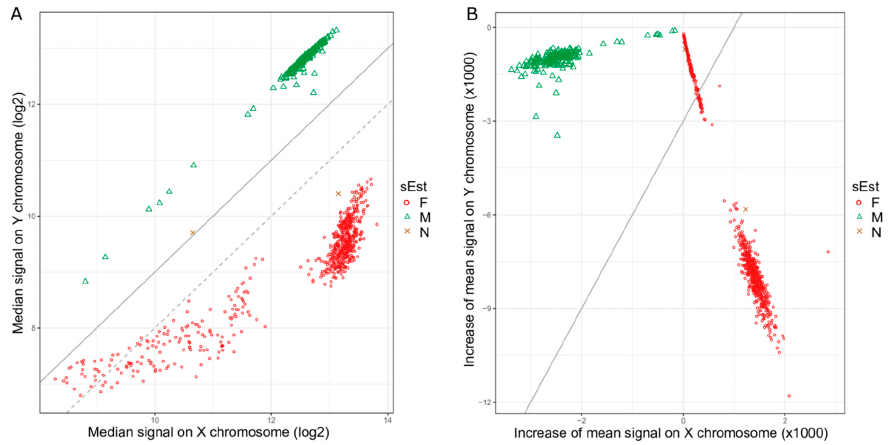
Figure 6 . Signal intensity plots for dataset GSE51032. ( A ) The median signal intensity of chrX probes (xMed) against the median signal intensity of chrY probes (yMed) in log2-scale for each sample. The grey dotted line indicates the default cut-off of − 2 for the difference between xMed and yMed (yMed − xMed) that the ‘getSex’ function of minfi package uses. A lot of red circles are above this line and are classified as Male by the ‘getSex’ function using the default parameters. Changing the cut-off to − 1 (grey solid line) would reclassify the red circles above the grey dotted line as Female. ( B ) Increase in mean signal intensity on chrX and chrY compared to mean signal intensity on all autosomes. The grey solid line represents the cut-off line, which passed through a cluster of female samples, resulting in a large number of misclassified samples.